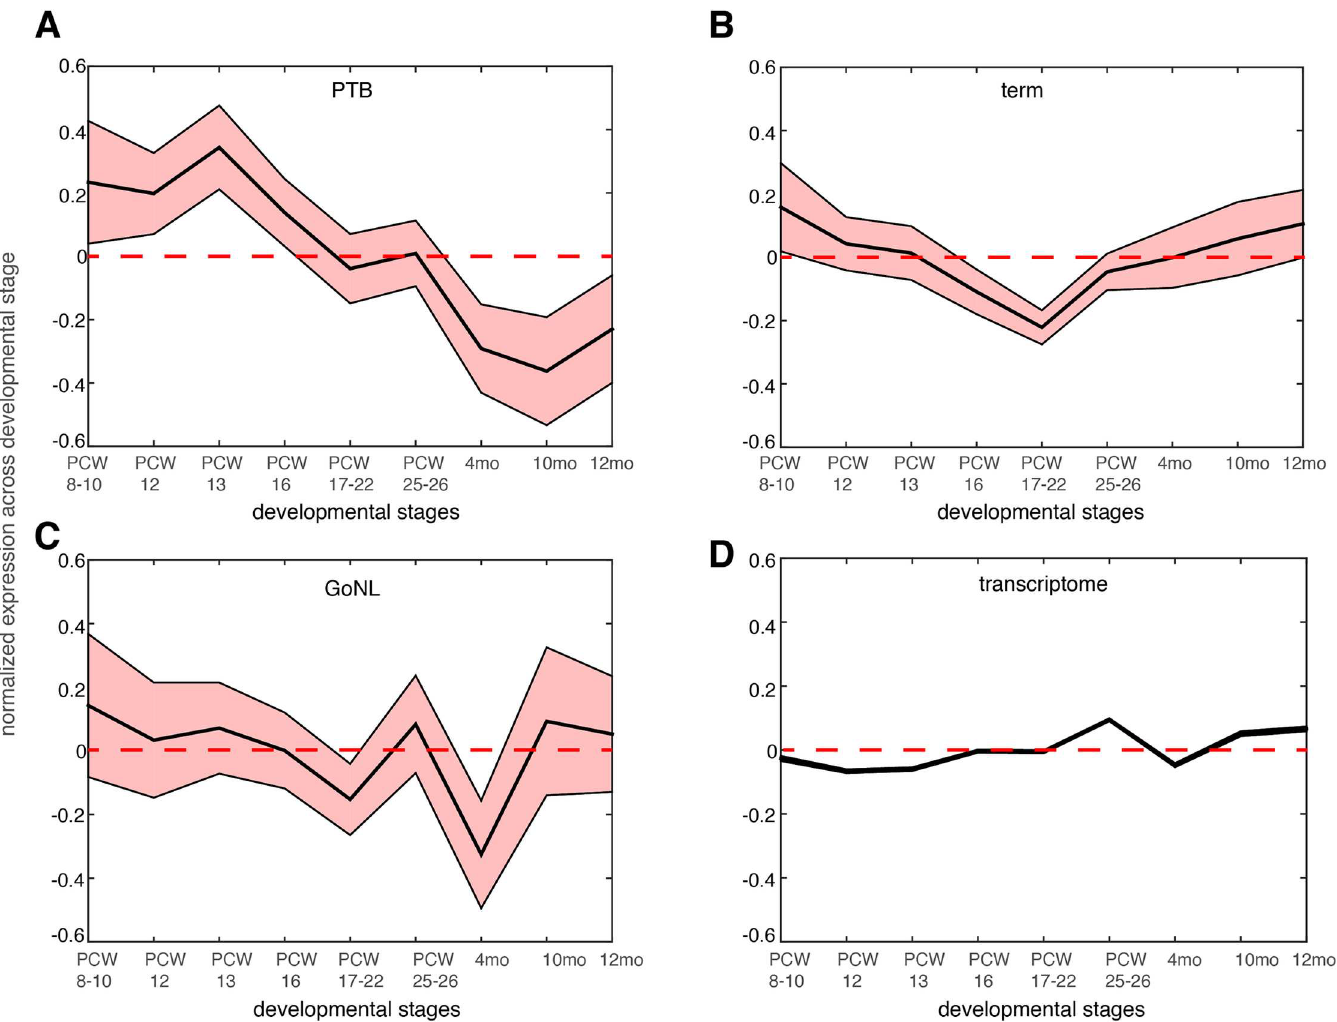
Fig 4. Gene expression dynamics during nine different neocortical developmental stages. The developmental stages includepost-conceptual week (PCW) 8–10, PCW 8–12, PCW 13, PCW 16, PCW 17–22 and postnatal4 months, 10 months and 12 months. The mean expressionlevel togetherwith the standarderror of the mean (SEM) was plotted across the developmental stages for genes affected by de novo mutations identified in the PTB (panel a ), term (panel b ) and GoNL (panel c ) cohorts. The same analysiswas also performed on the entire transcriptome in each temporalepoch (panel d, the SEM is too small to be shown due to large sample size, i . e . overall20,000 genes included). Gene expressionvalues were normalized across different developmental